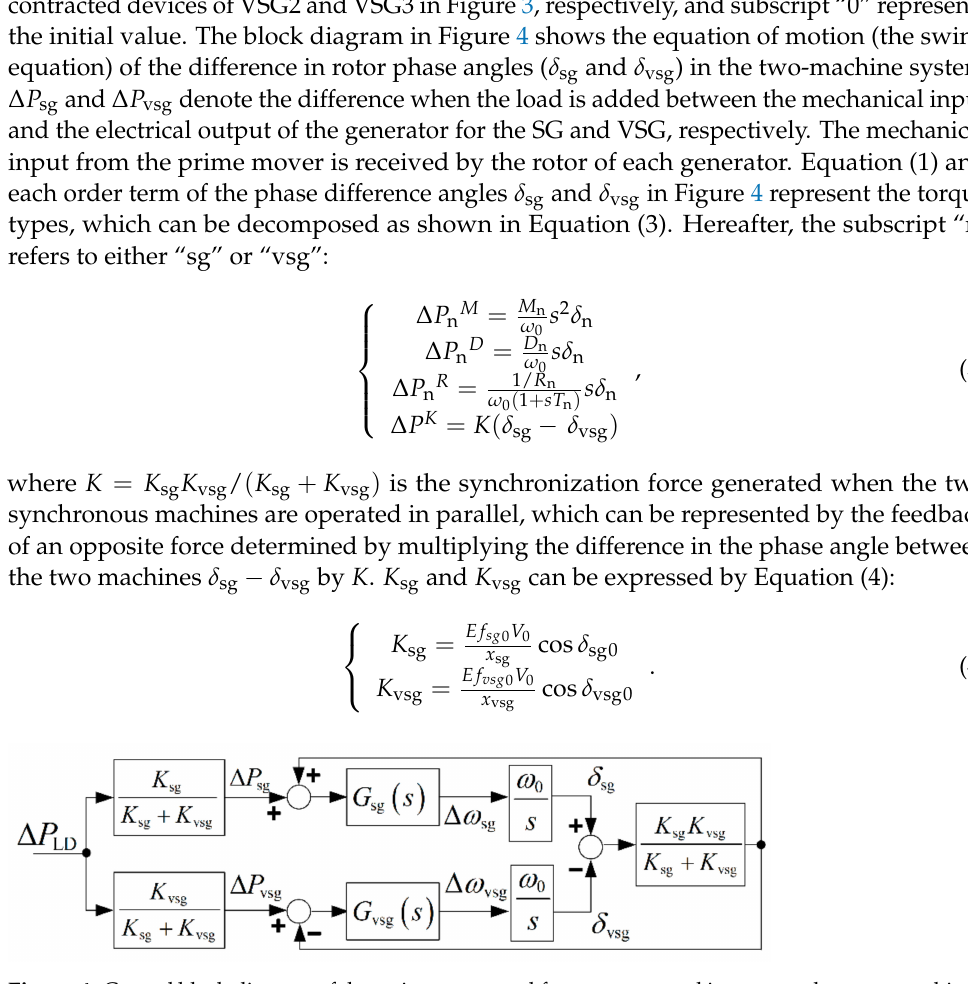
Figure 4. Control block diagram of the active power and frequency control in two synchronous